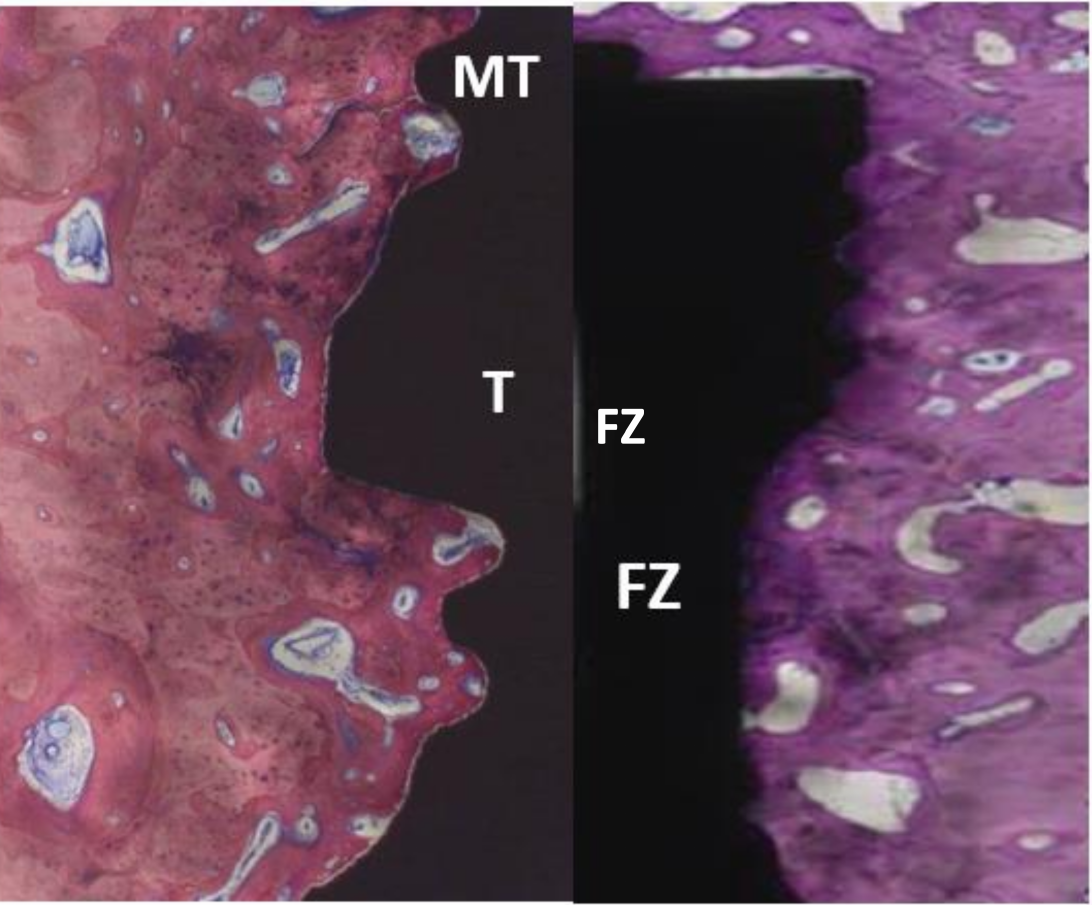
Figure 4. Typical micrographs of the coronal aspect of implants after 1 m and 3 m, revealing new bone close to the implant profile along with blood vessels with no signs of inflammation. MT, microthread; T, thread; FZ, flute